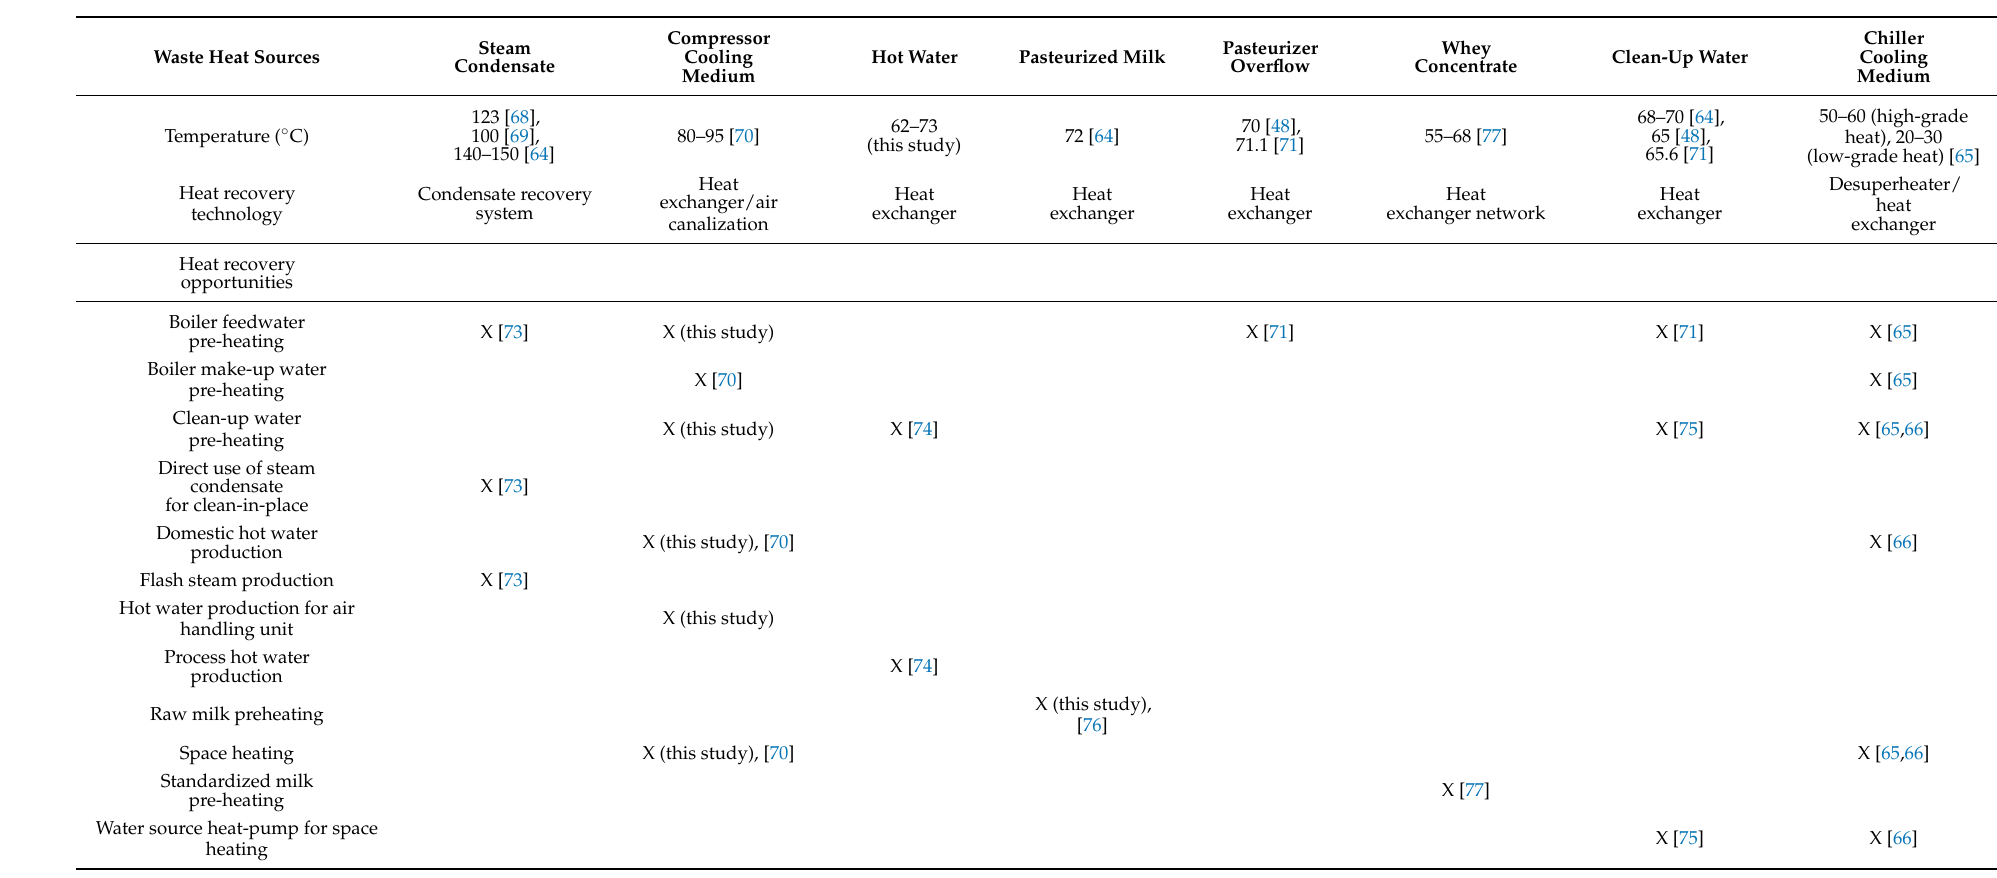
Table A10. Scheme providing the characterization of waste heat sources from yoghurt production and the identification of possible heat